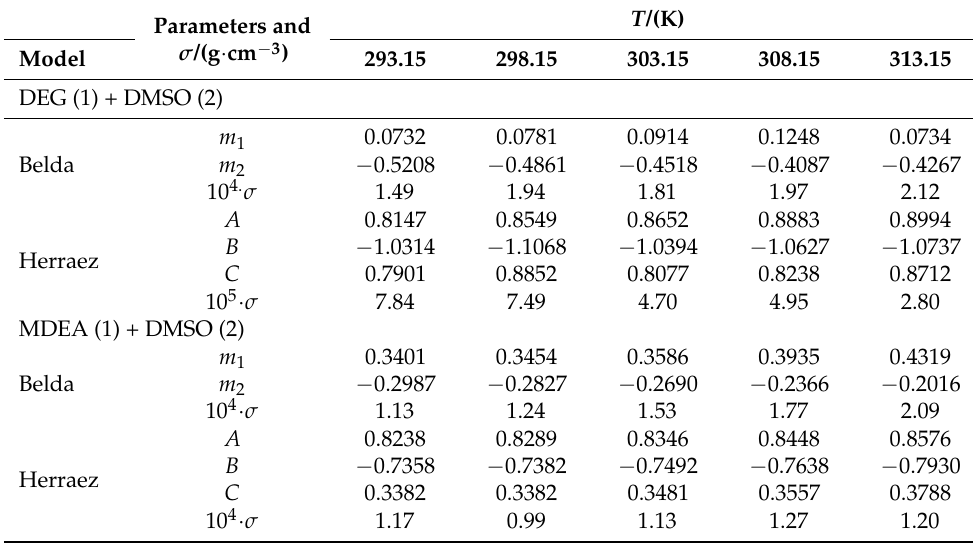
Table A1. Parameters for the Belda and Herraez equations and standard deviations at temperature range from (293.15 to 313.15) K.